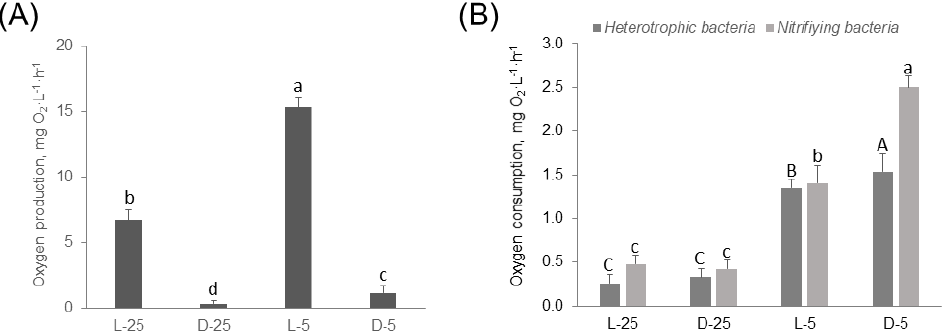
Figure 4. ( A ) Microalgae activity at different influent concentration and under light/dark conditions. ( B ) Heterotrophic and nitrifying activity at the different experiments. Different letters indicate significant differences.